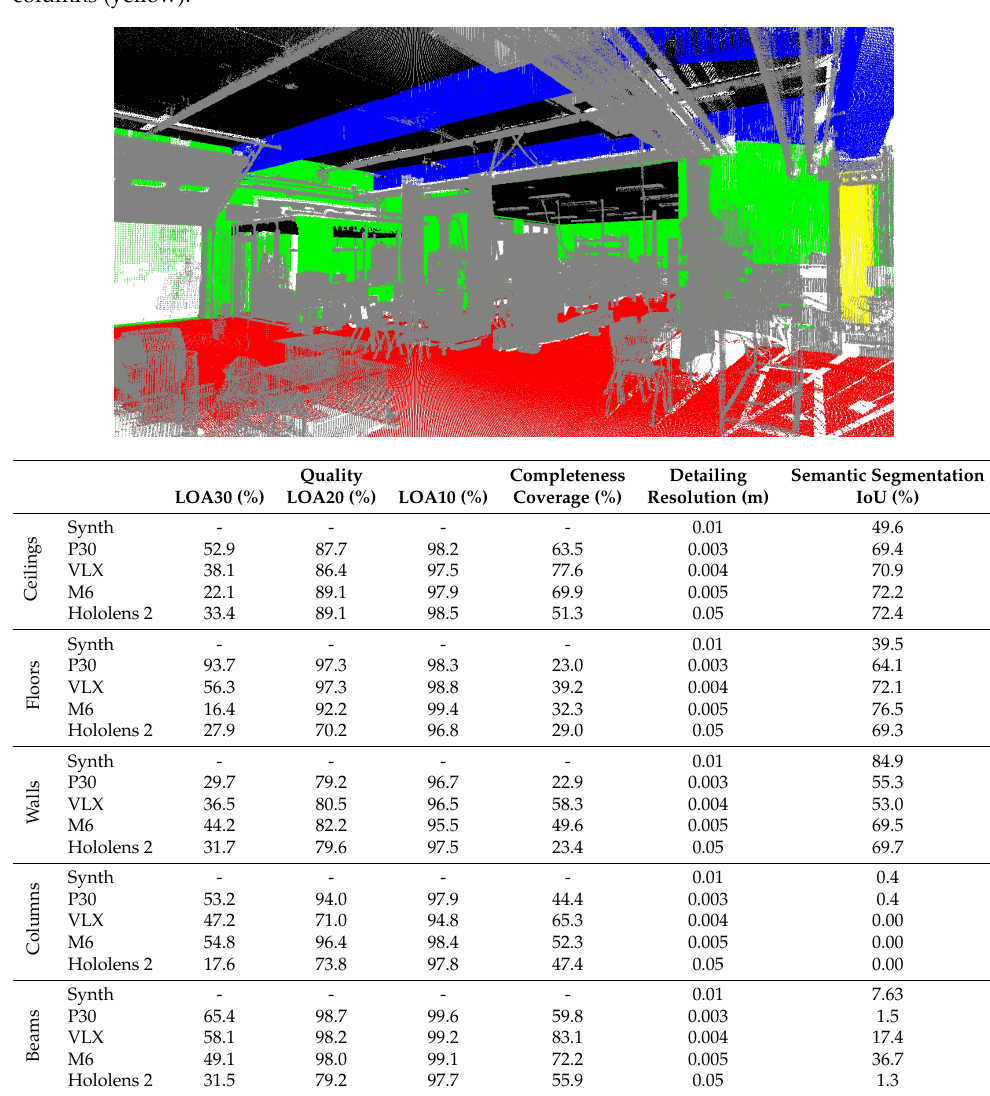
Table 4. Results of the point cloud and semantic segmentation testing (Lab 1): Comparative study of the input-validation parameters. Ceilings (black), floors (red), walls (green), beams (blue), and columns